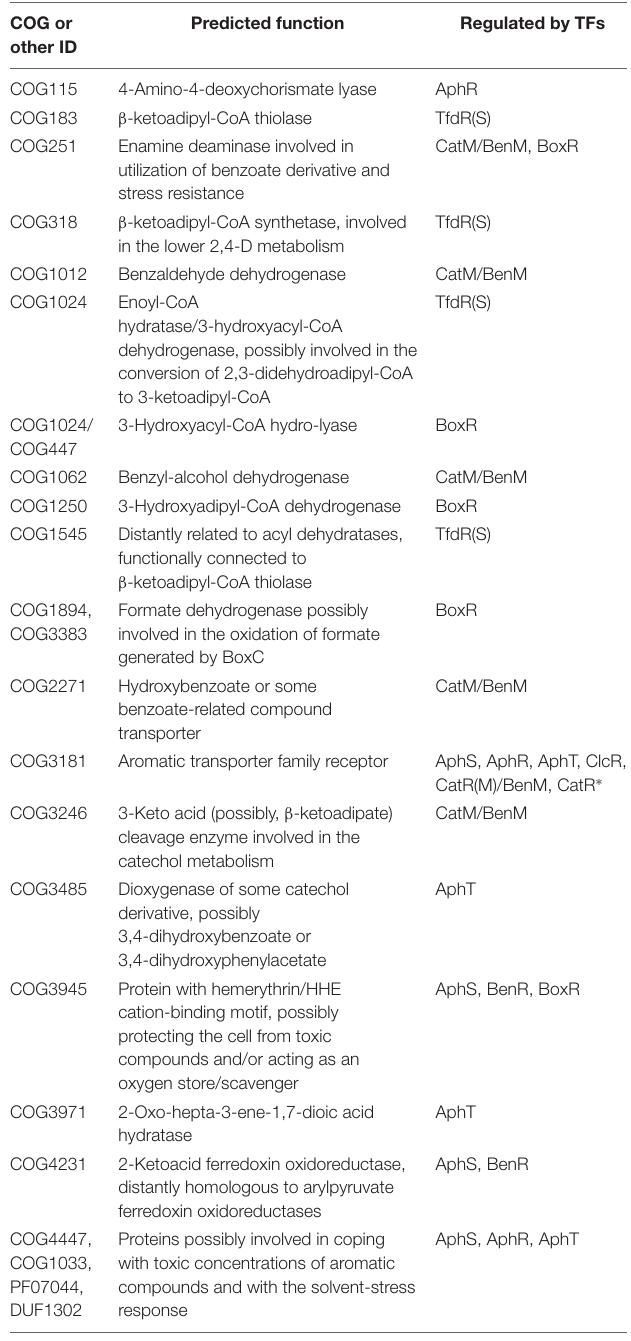
TABLE 1 | Predicted functions of the main new members of aromatic